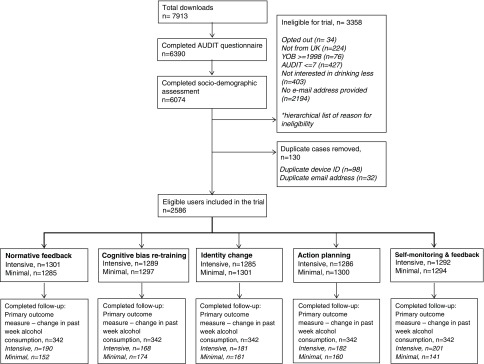
Flow chart of users.